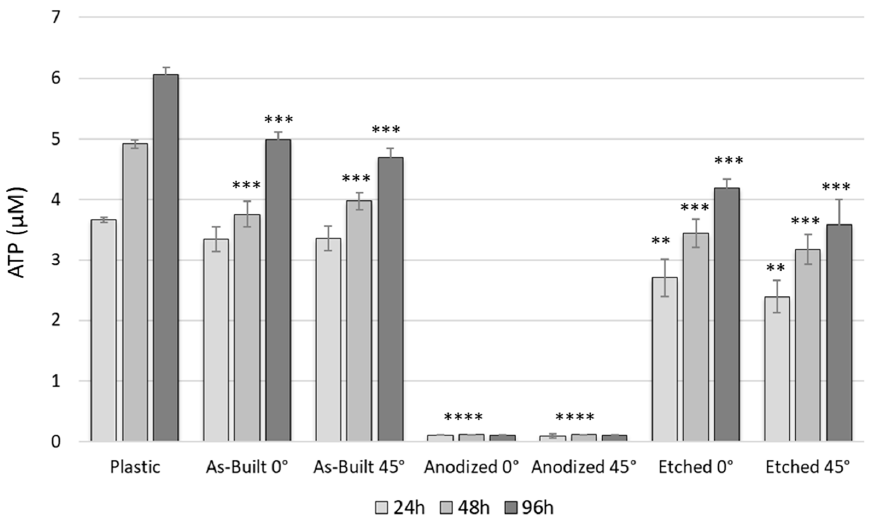
Figure 5. ATP ( μ m) concentrations of MC3T3-E1 cells cultured on titanium as-built, anodized and etched 0° and 45° SLM scaffolds and on a plastic dish after 24 h, 48 h, and 96 h. Unpaired t -test was applied to discriminate differences between MC3T3-E1 cultured on a plastic dish and on each